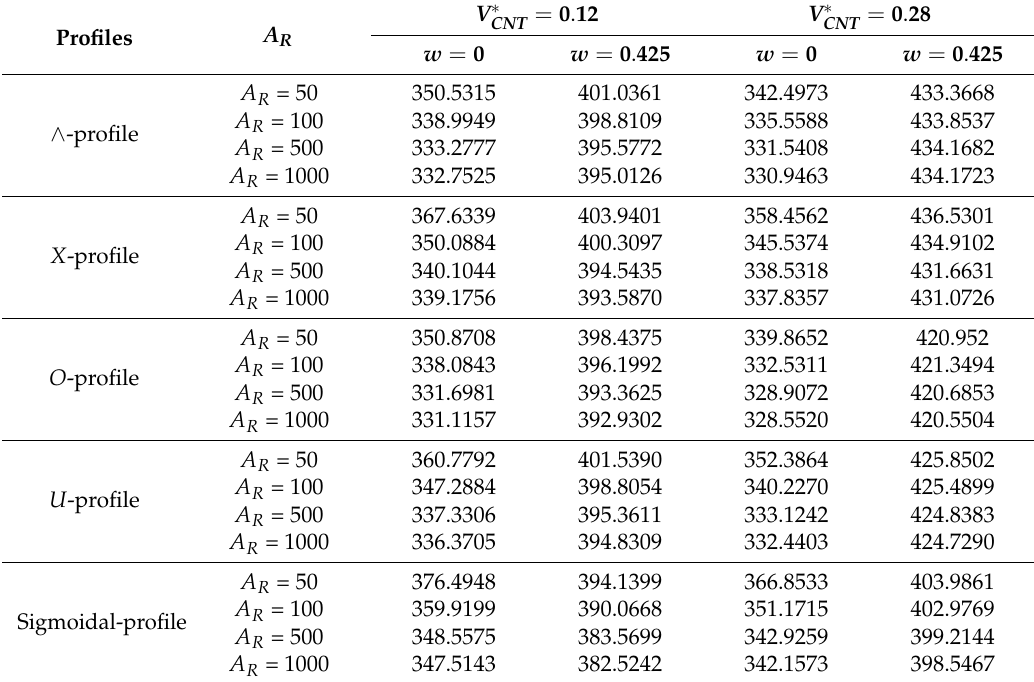
Table 4. Critical thermal buckling load for different distributions of the CNTs within the structure made of TD properties considering L / R = 1, R / h = 200, N r = 0, N s =